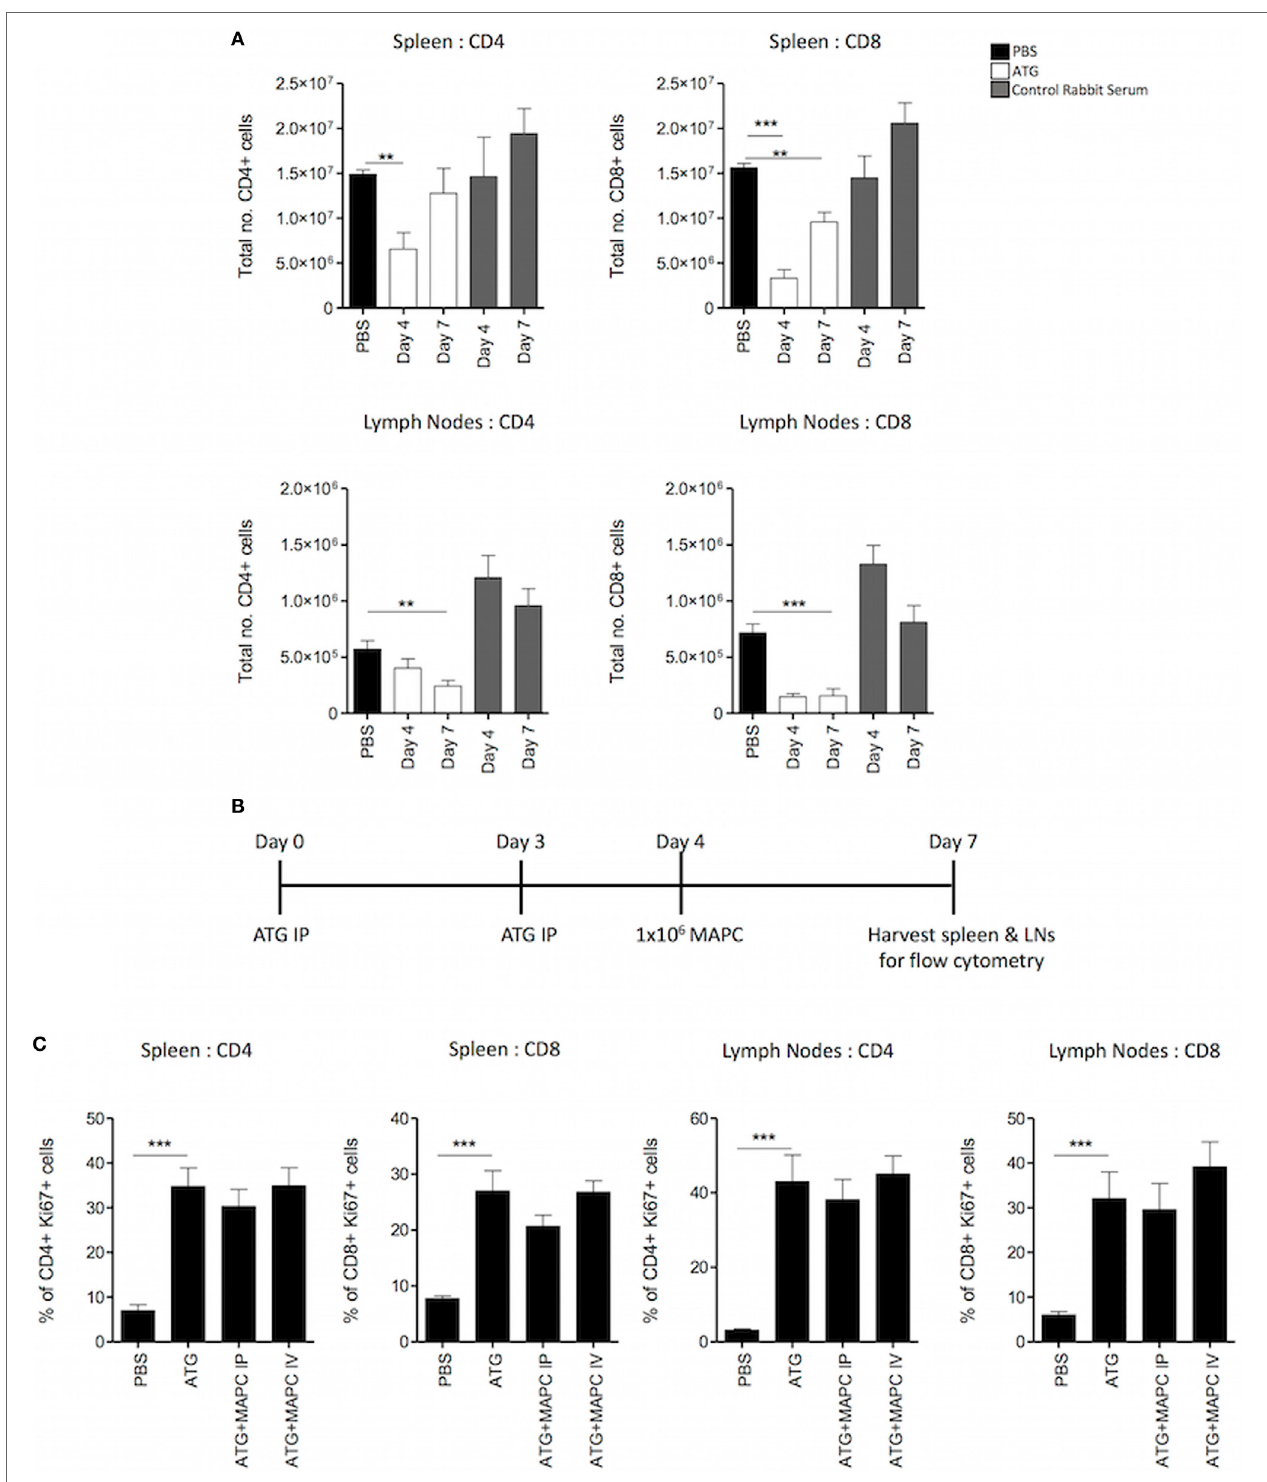
FigUre 3 | Multipotent adult progenitor cells (MAPC) have no effect on T cell proliferation following lymphodepletion. 50 mg/kg anti-thymocyte globulin (ATG) was administered intraperitoneally (IP) on days 0 and 3. (a) Spleens and lymph nodes were harvested on days 4 and 7, and total numbers of CD4 + and CD8 + cells were quantified using counting beads and flow cytometry. (B) Schematic timeline of experiments with MAPC (1 × 10 6 ) administration [IP or intravenously (IV)] to the ATG model on day 4. (c) MAPC administered IV or IP had no effect on the proliferation of either CD4 + or CD8 + T cells in the spleens and lymph nodes following ATG administration (spleens; PBS: n = 10, ATG: n = 10, ATG + MAPC IP: n = 10, and ATG + MAPC IV: n = 8 and lymph nodes; PBS: n = 8, ATG: n = 10, ATG + MAPC IP: n = 9, and ATG + MAPC IV: n = 10). Results are indicative of two independent experiments using two MAPC donors. * < 0.05, ** p < 0.01, and *** p < 0.001.